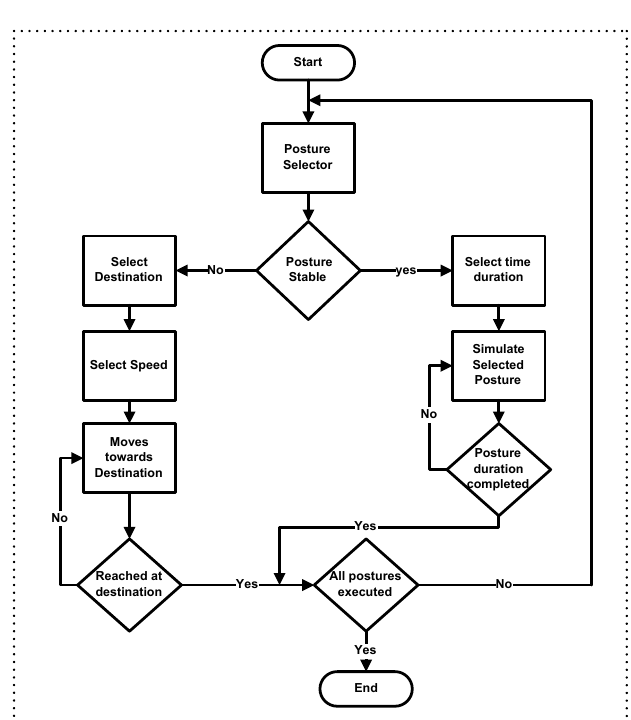
Figure 1. WBAN architecture.